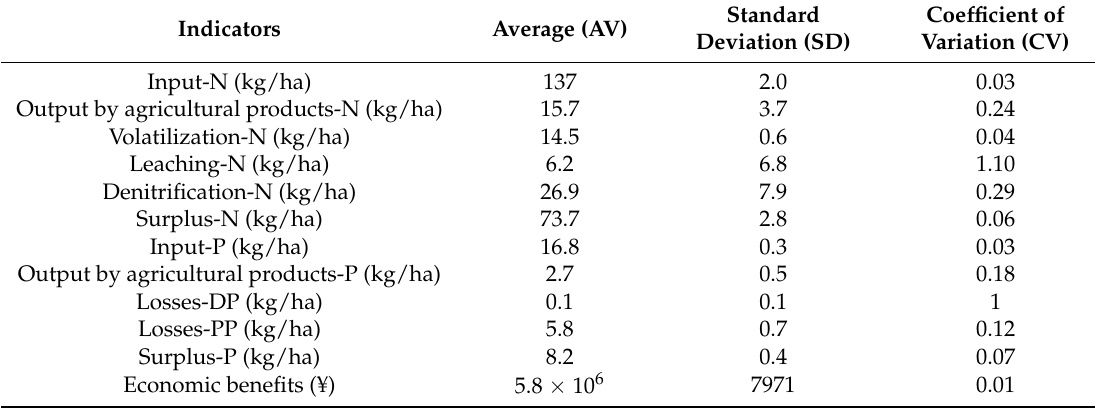
Table 2. Descriptive statistics analysis of nutrients balance in VNWY from 2000 to 2014.